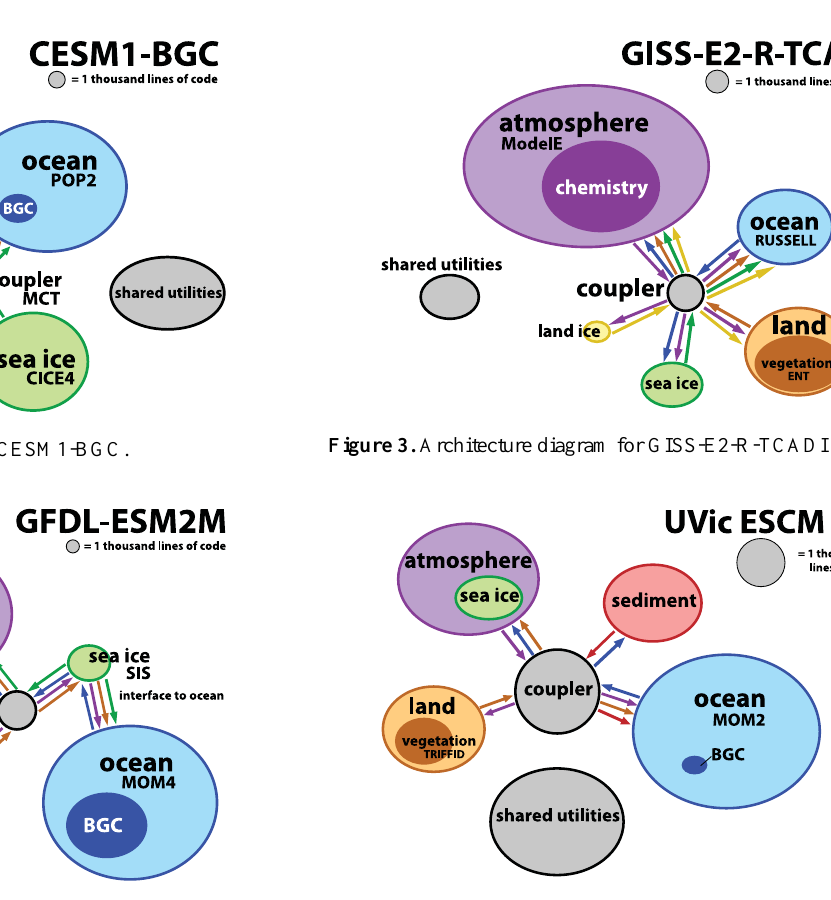
Figure 2. Architecture diagram for GFDL-ESM2M.